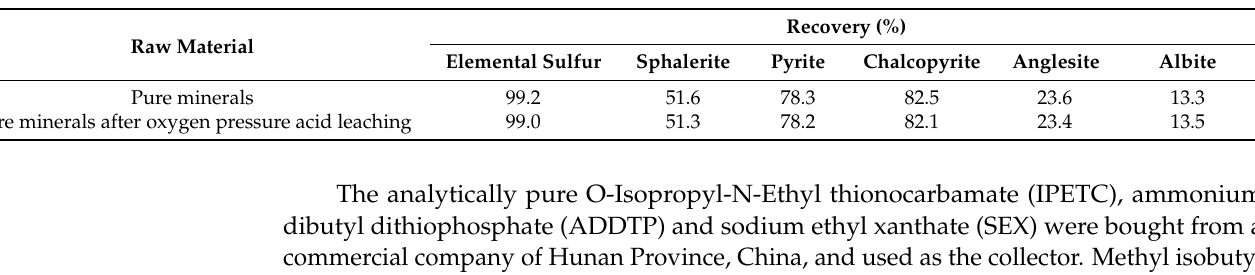
Table 4. The flotation results of pure minerals and pure minerals after oxygen pressure acid leaching whose conditions are the following: initial sulfuric acid concentration, 60 g/L, temperature, 150 ◦ C, oxygen partial pressure, 1.0 MPa and time, 2.5